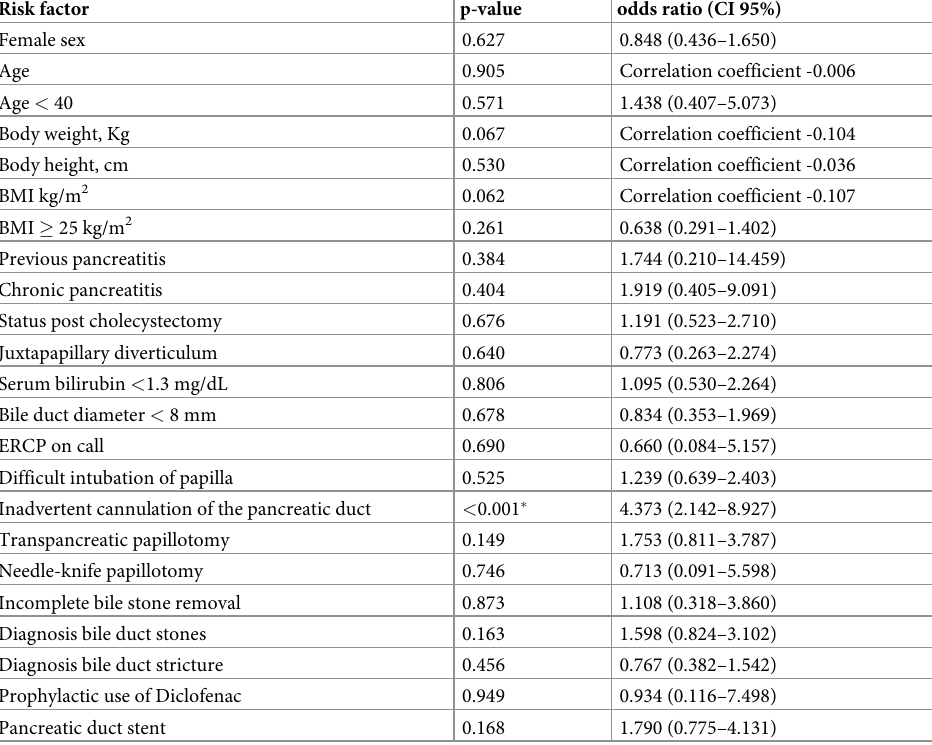
Table 2. Risk factors for post-ERCP